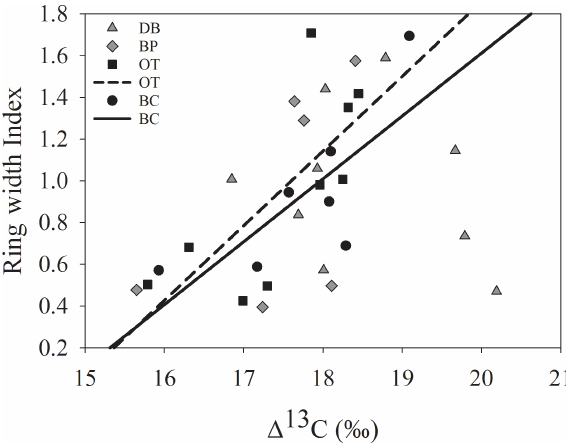
Figure 7. Relationship between ARSTAN ring width index and tree ring (cid:49) 13 C. Site DB is represented by gray triangles, BP by gray diamonds, OT by black squares and BC by black circles. Regression lines are shown only for statistically significant